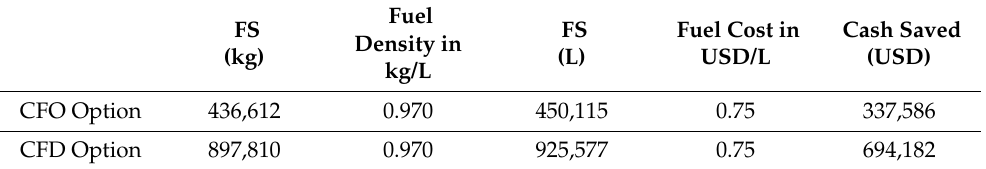
Table 9. Potential fuel savings under CFO and CFD for the year 2020 and corresponding cash